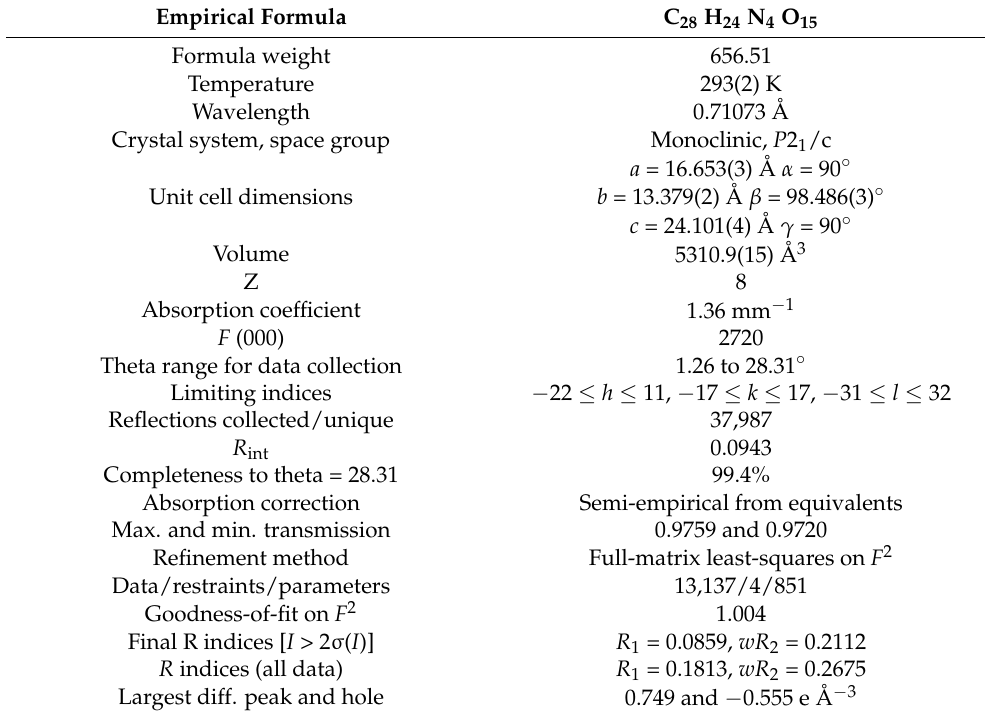
Table 1. Crystal data and structure refinement for compound 1